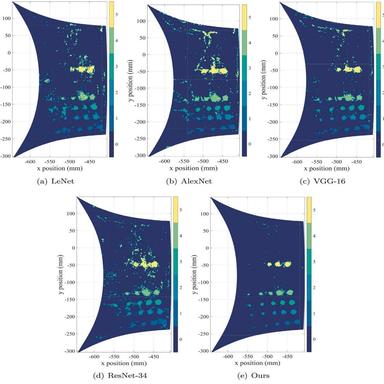
The characterization and visualization results of five trained models on the testing dataset.